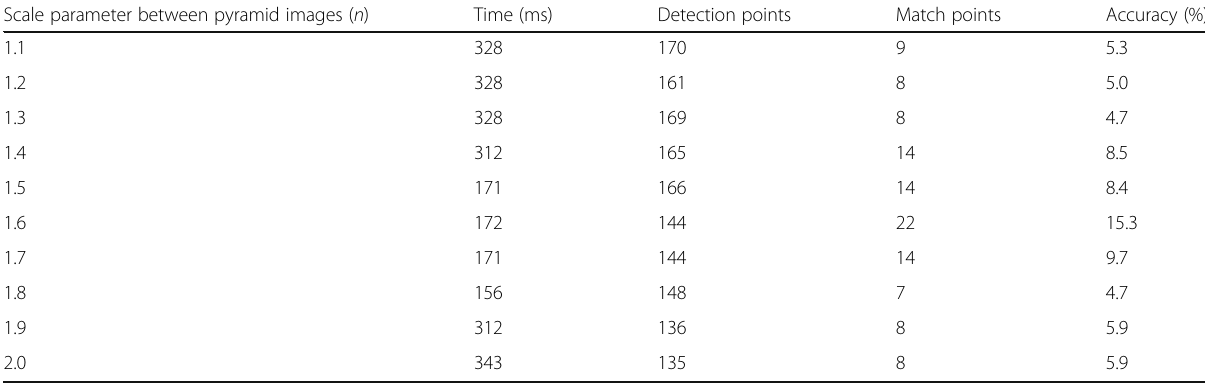
Table 5 Statistics table of the results of the constant change of the inter-image scale parameters when the pyramid layer is 4 Scale parameter between pyramid images ( n ) Time (ms) Detection points Match